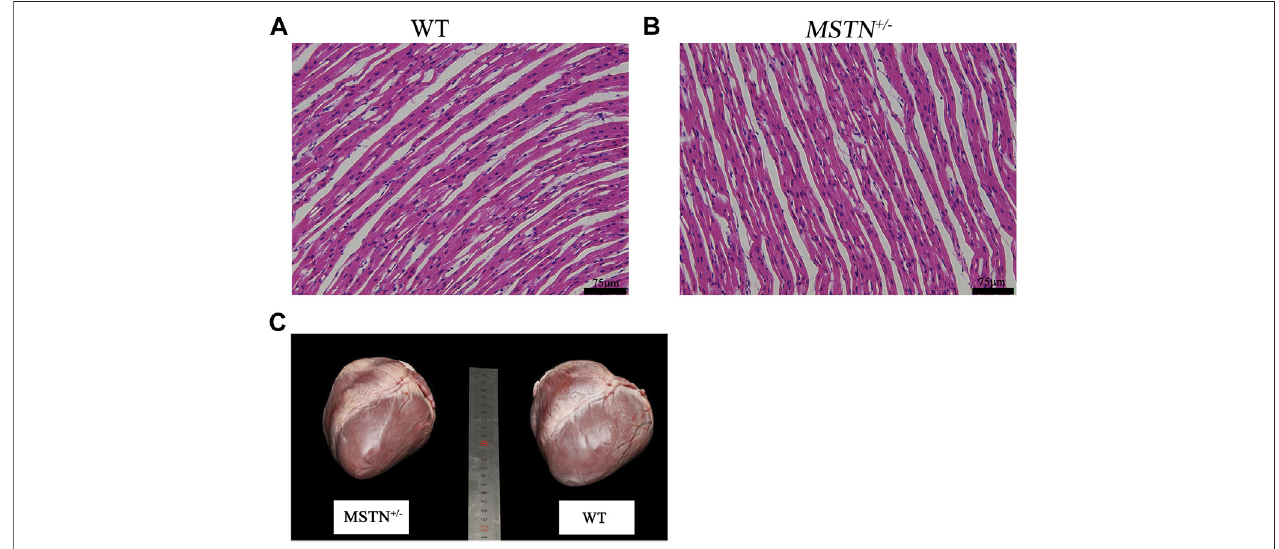
FIGURE 2 | Histological analysis of duodenum, jejunum, and ileum in 5- month-old MSTN +/ − and WT pigs. (A – C) Representative pictures of HE staining in duodenum (A) , jejunum (B) , and ileum tissue of WT (left) and MSTN +/ − (right) pigs.